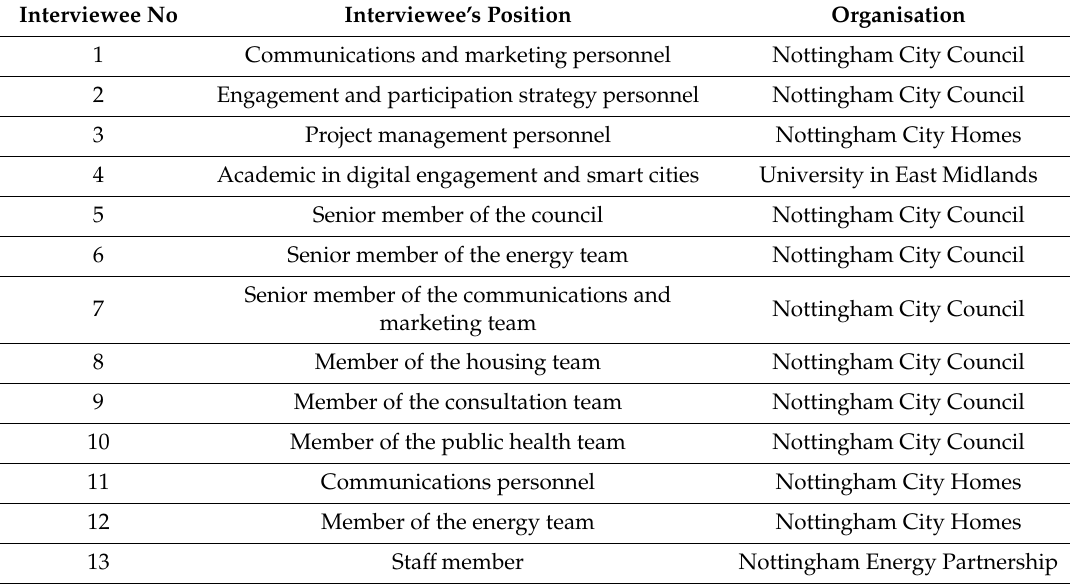
Table 1. List of the